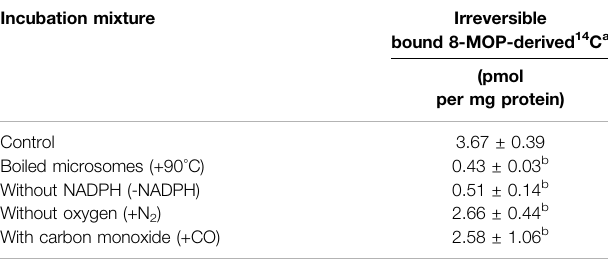
TABLE 5 | The effects of different incubation conditions on the amounts of irreversibly bound radioactivity formed in human liver